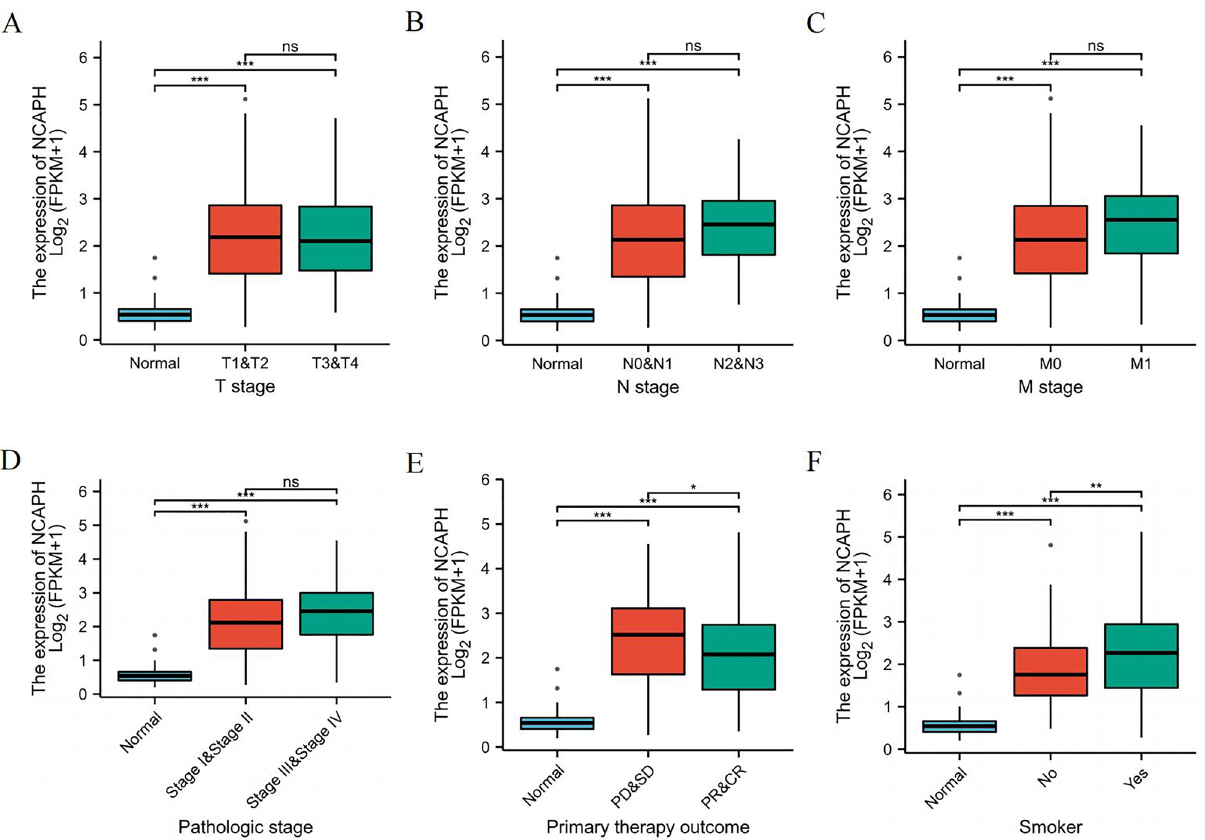
Figure 4. Correlation with NCAPH expression and clinicopathological characteristics, including ( A ) T stage, ( B ) N stage, ( C ) M stage, ( D ) pathologic stage, ( E ) primary therapy outcome, ( F ) smoke status in LUAD patients in TCGA cohort.* P < 0.05,** P < 0.01,*** P < 0.01.